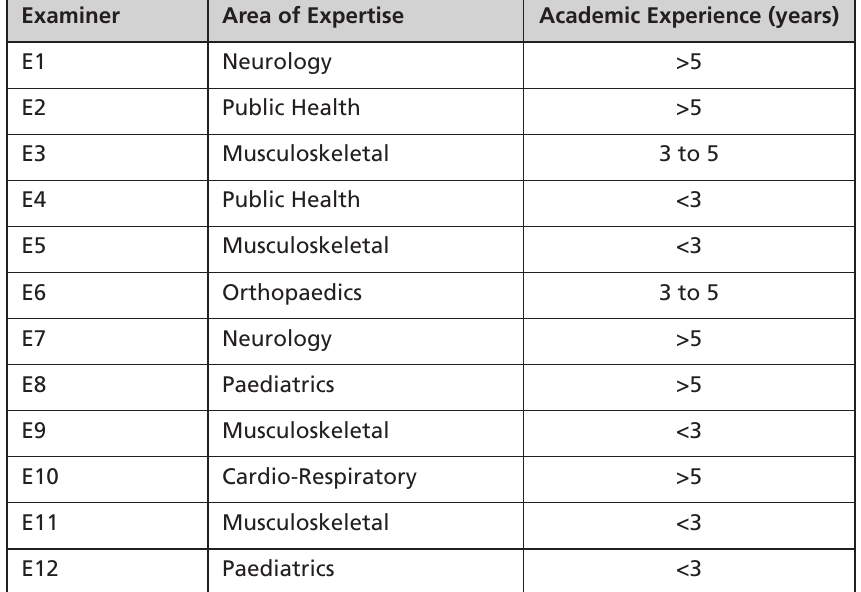
Table 1: Area of expertise and level of experience of examiners